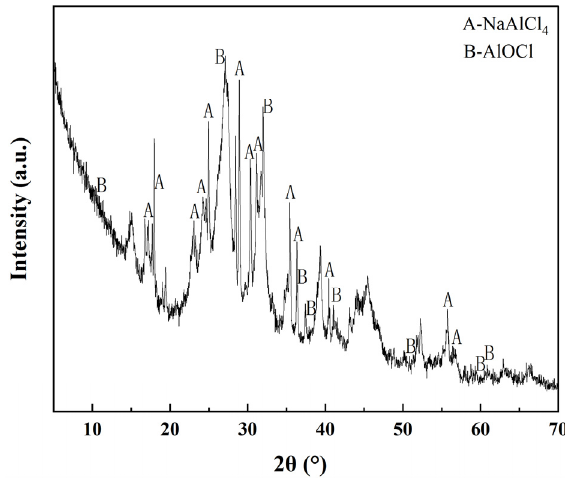
Figure 11. XRD pa tt ern of chlorination residue during chlorination. Figure 11. XRD pattern of chlorination residue during